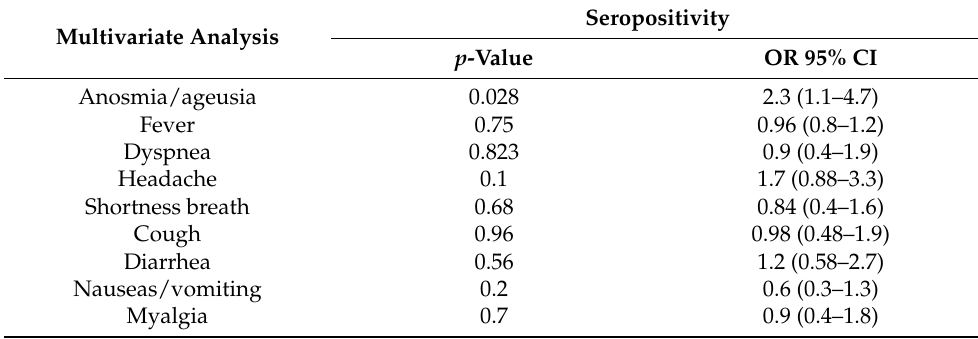
Table 5. Multivariate analysis among the cluster of clinical manifestations associated with COVID19 with the probability of being seropositive for